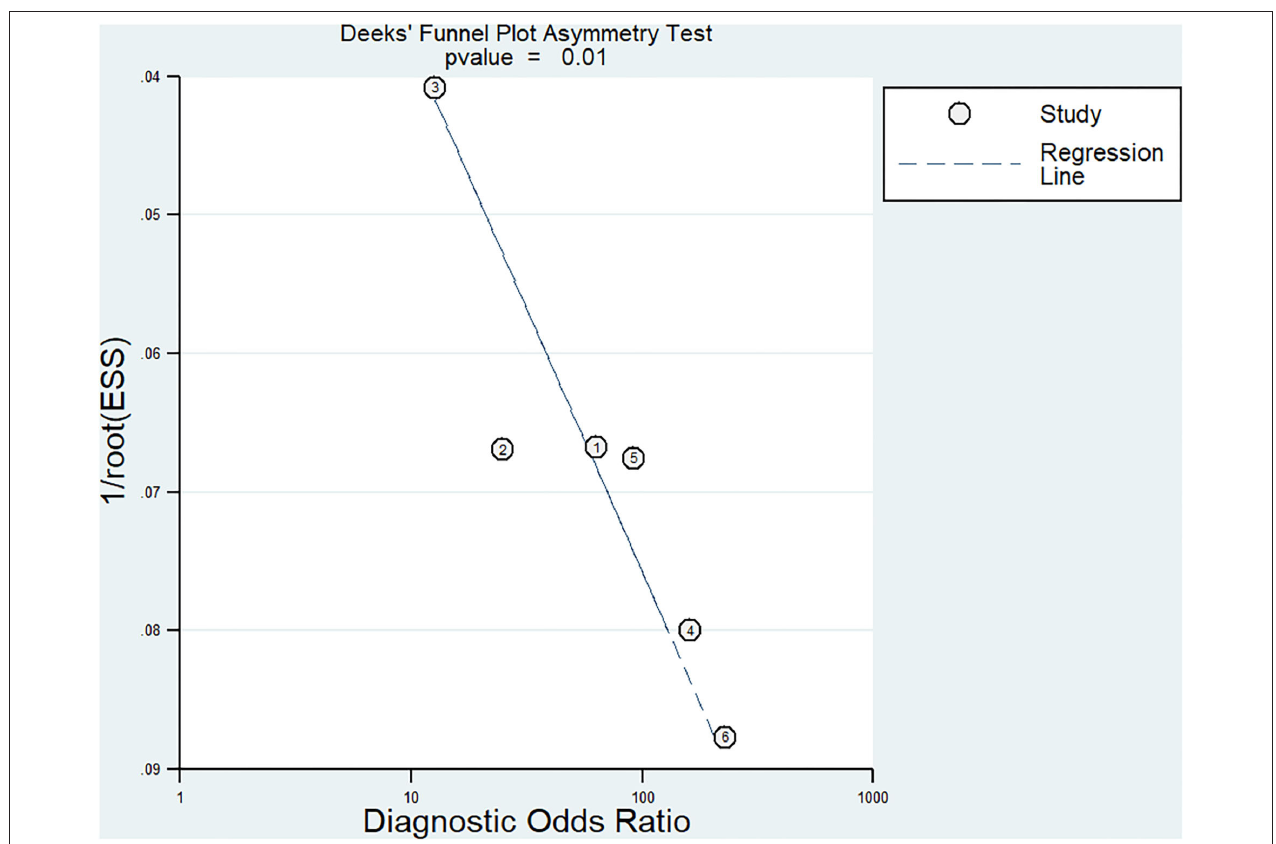
FIGURE 7 | Summary receiver operating characteristic